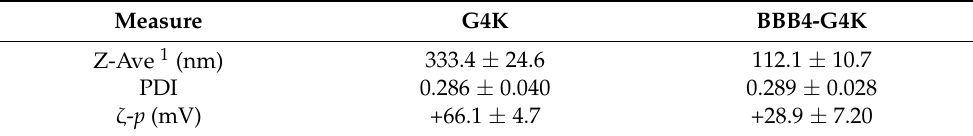
Table 5. Results obtained from DLS analyses on G4K NPs and BBB4-G4K NPs: particle size (Z-ave, nm), PDI, and ζ - p